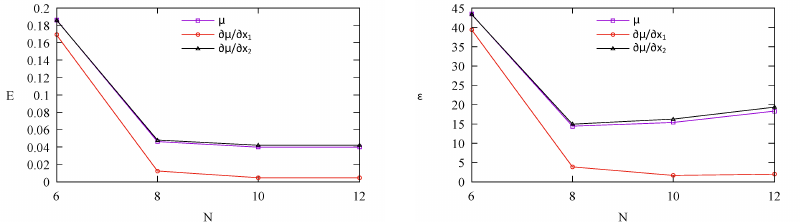
Figure 6. The aggregate relative error E and efficiency number ε = τE for Case 3.